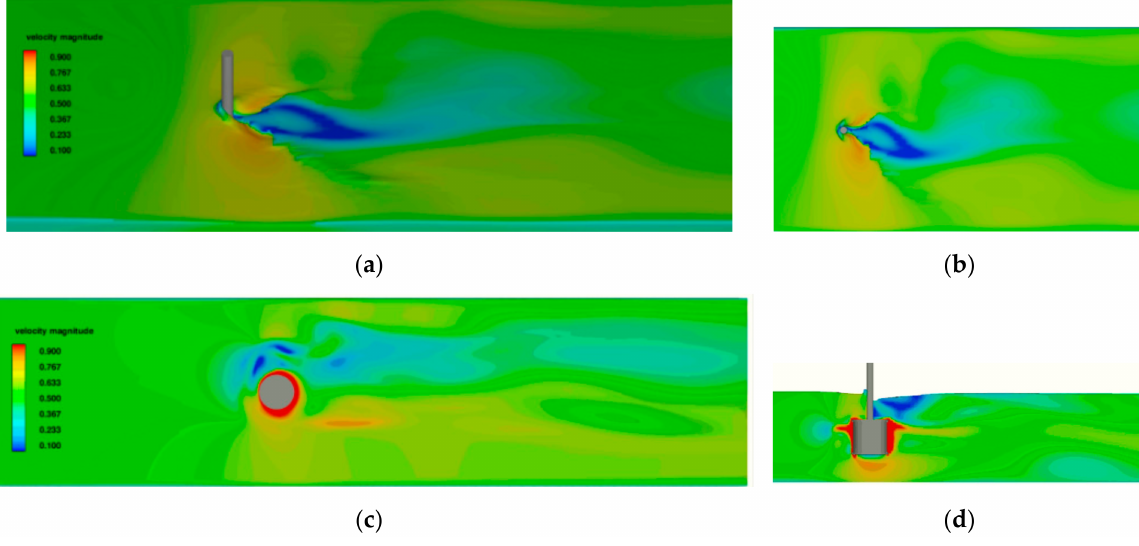
Figure 13. Results of 3D flow simulation for V = 0.50 m/s: ( a ) perspective view of velocity field on the free surface, ( b ) top view of velocity field on the free surface, ( c ) velocity field in the horizontal plane at half-length section of the rotor, and ( d ) velocity field in the rotor symmetry